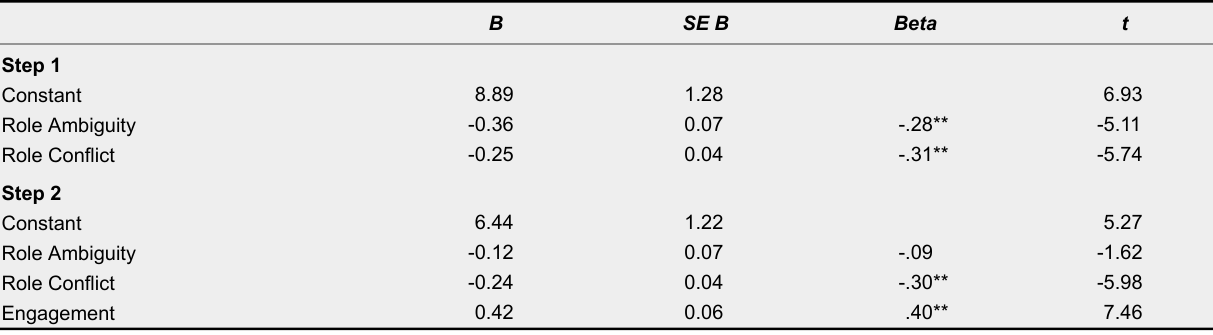
Hierarchical Regression Results for Job